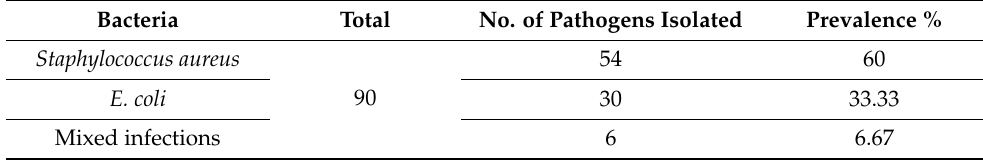
Table 6. Incidence of pathogens isolated from the milk of subclinical mastitis